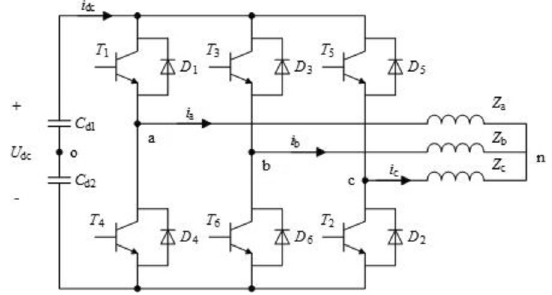
Fig. 1 The topology structure of drive